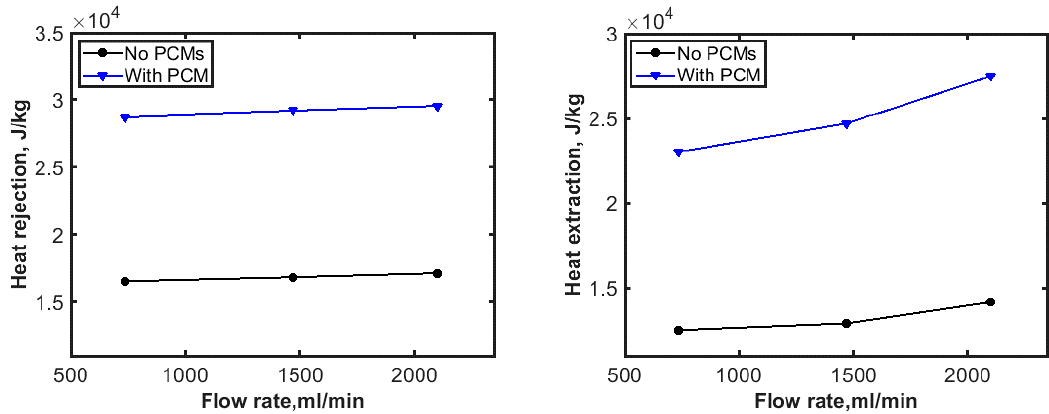
Figure 16. Effect of PCM on storage capacity. Figure 16. E ff ect of PCM on storage